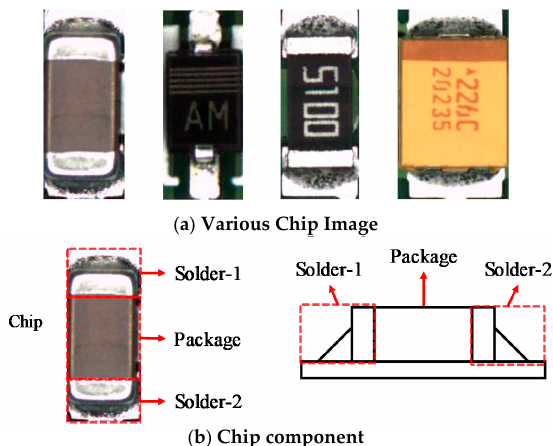
Figure 2. Chip components: ( a ) various chip components mounted on the printed circuit board (PCB), ( b ) top view (left) and side view (right) of chip component. Each pixel vector (cid:1861) (cid:3040)(cid:3041) ∈ (cid:1844) (cid:2869)×(cid:2871) (cid:4666)(cid:1865) = 1,⋯,(cid:1839),(cid:1866) = 1,⋯,(cid:1840)(cid:4667) of the (cid:1839) × (cid:1840) image input from the illumination system includes red, green, and blue pixel values.